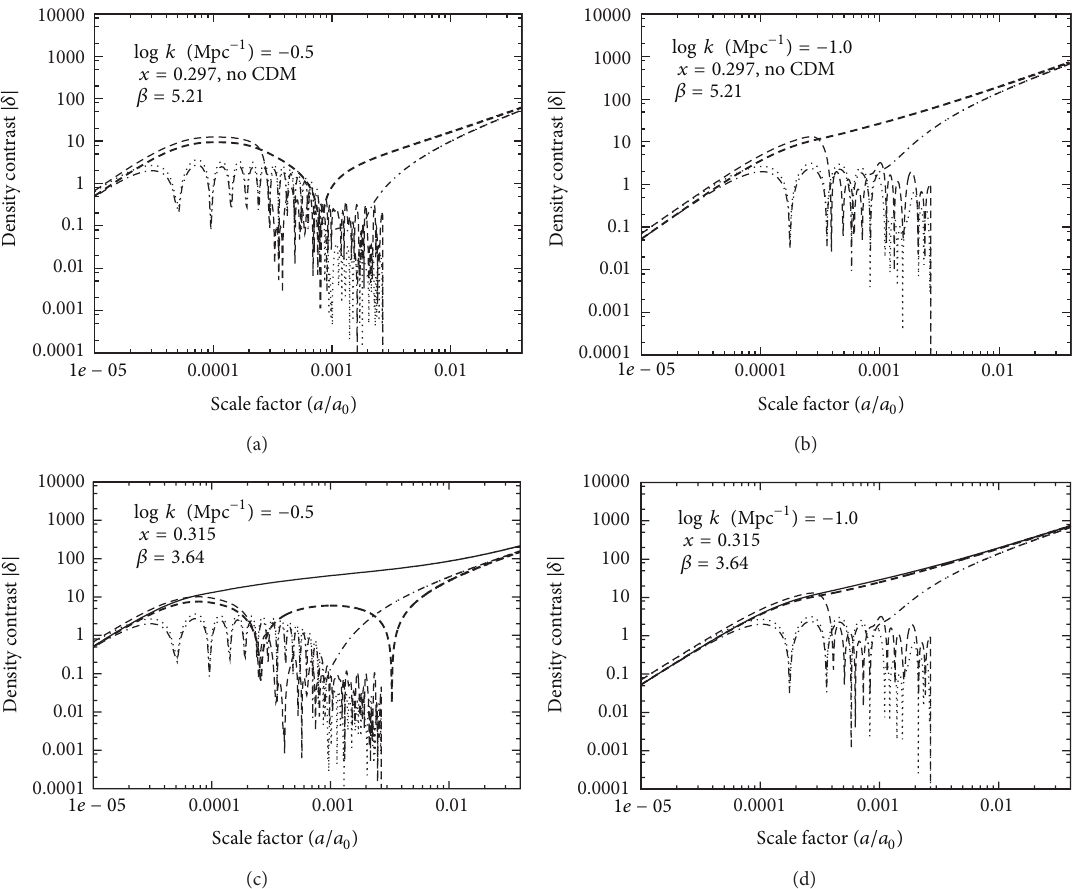
Figure 3: Evolution of the density perturbations of the different components of a mirror Universe: cold dark matter (solid), ordinary baryons (dot-dashed), ordinary photons (dotted), mirror baryons (long dashed), and mirror photons (dashed). The models correspond to the parameters of Table 2 obtained with the CMB and LSS data. (a) Pure mirror case at the scale log 𝑘( Mpc −1 ) = −0.5 . (b) Pure mirror case at the scale log 𝑘( Mpc −1 ) = −1.0 . (c) Mixed mirror-CDM case at the scale log 𝑘 ( Mpc −1 ) = −0.5 . (d) Mixed mirror-CDM case at the scale log 𝑘( Mpc −1 ) = −1.0